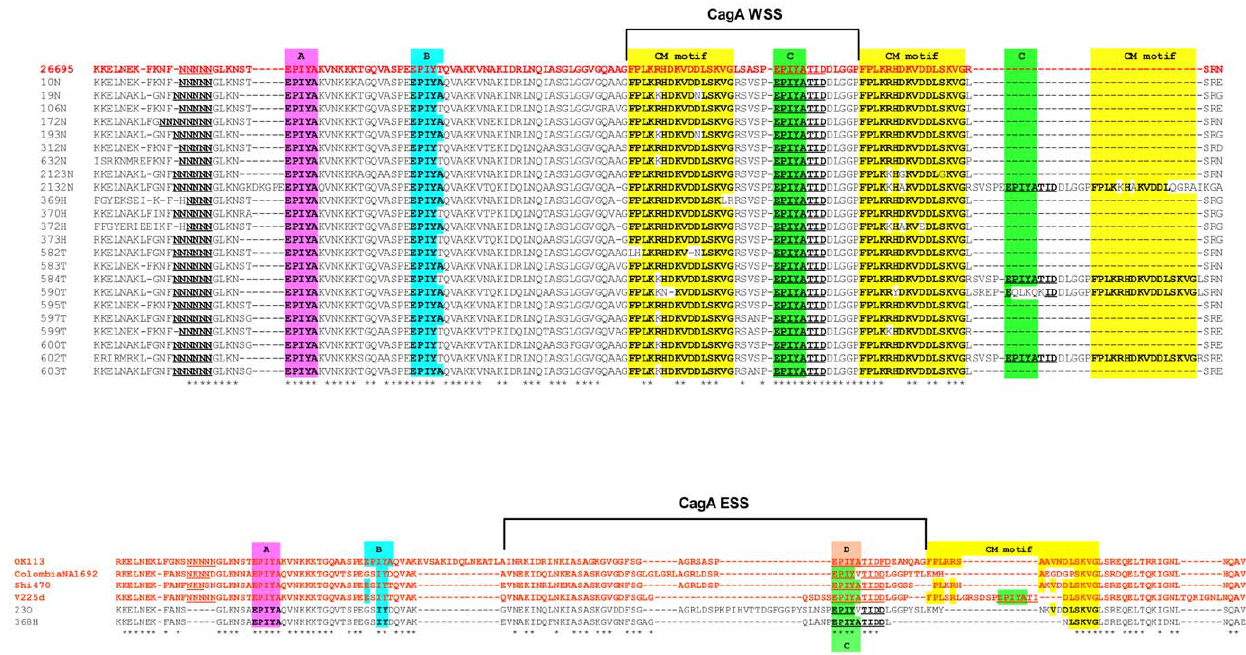
Figure 1. Alignment of amino acid sequences of the CagA 3’ region of H.pylori strains from Mexican native groups. a) Most strains presented a Western-type sequence, with an EPIYA ABC pattern and two CM motifs. The sequence of strain 26695 was used as reference. b) One Huichol strain, 368H and one Otomi strain, 23O presented a chimeric sequence with some homology with Asian-type sequences, with insertions, deletions and substitutions and similar to the Colombian strain NA1692. Sequences are compared with the Japanese isolate OK113.